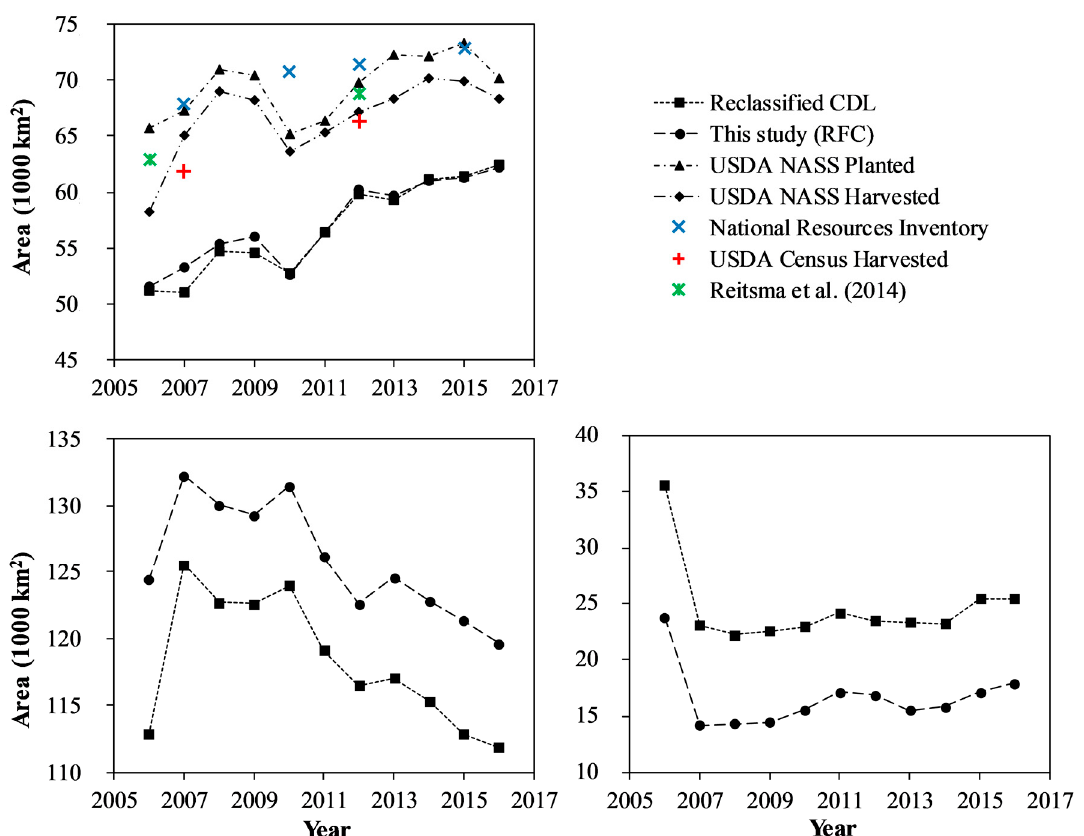
Figure 3. State-level comparison between estimated land cover areas from this study (Random Forest Classifier; RFC) and other data sources. Both United States Department of Agriculture (USDA) National Agriculture Statistics Service (NASS) Planted/ Harvested and Census of Agriculture for South Dakota data were retrieved from the NASS website [26–28] with no accuracy information. The 95% confident interval (CI) for 2007, 2010, 2012, and 2015 NRI data are ± 2138 km 2 , ± 1823 km 2 , ± 1525 km 2 , and ± 1708 km 2 , respectively [29–32]. Cropland areas found in [3] also did not have accuracy information.